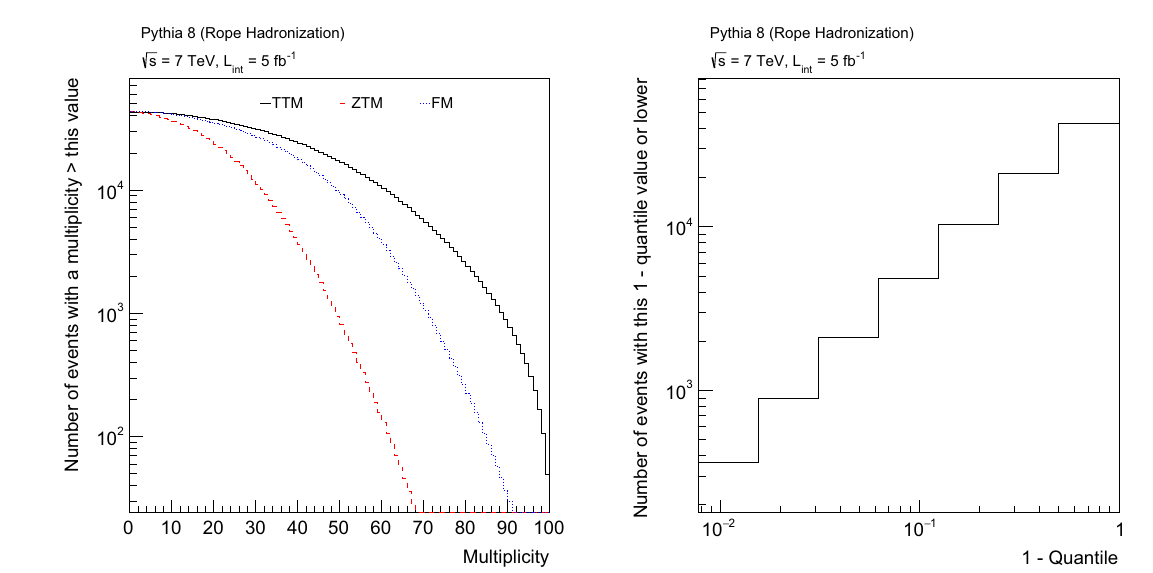
the multiplicity quantile (the same by construction for all multiplicity types). Higher multiplicities are on the left